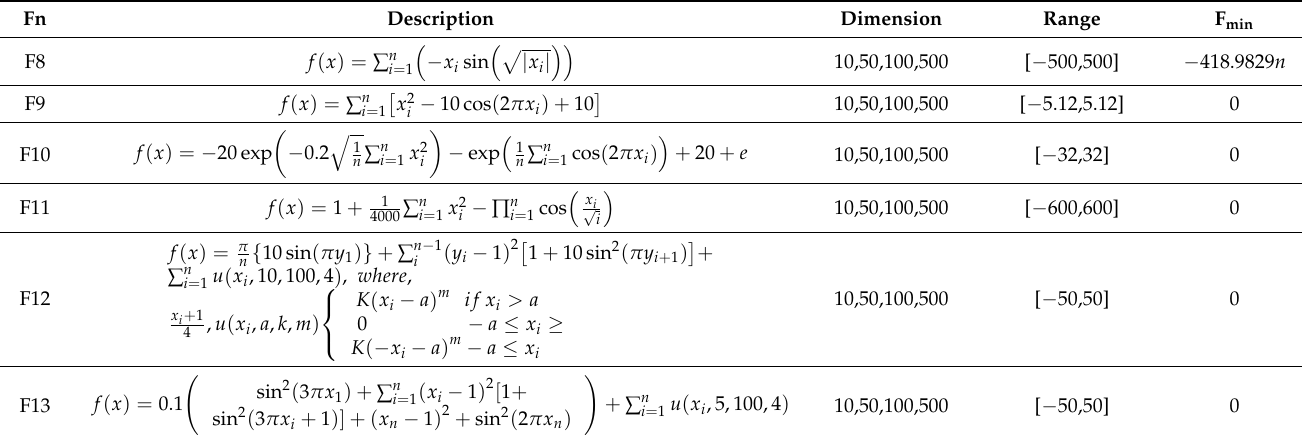
Table 3. Multimodal benchmark functions.